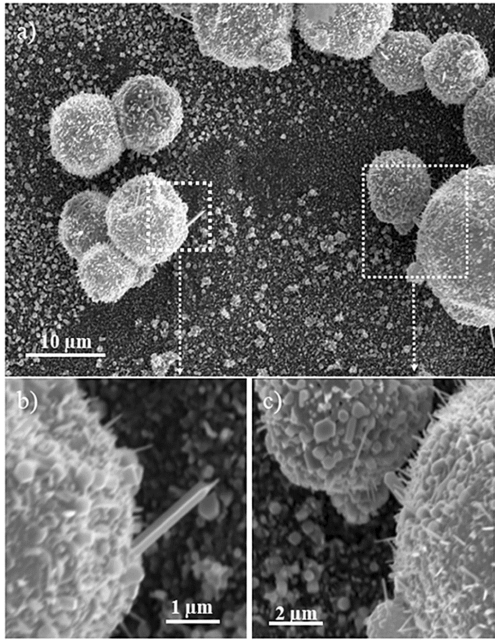
Figure 3. SEM image of ZnO spherical cages (0.5–15 µ m in size) grown on Au thin film at 700 ◦ C for